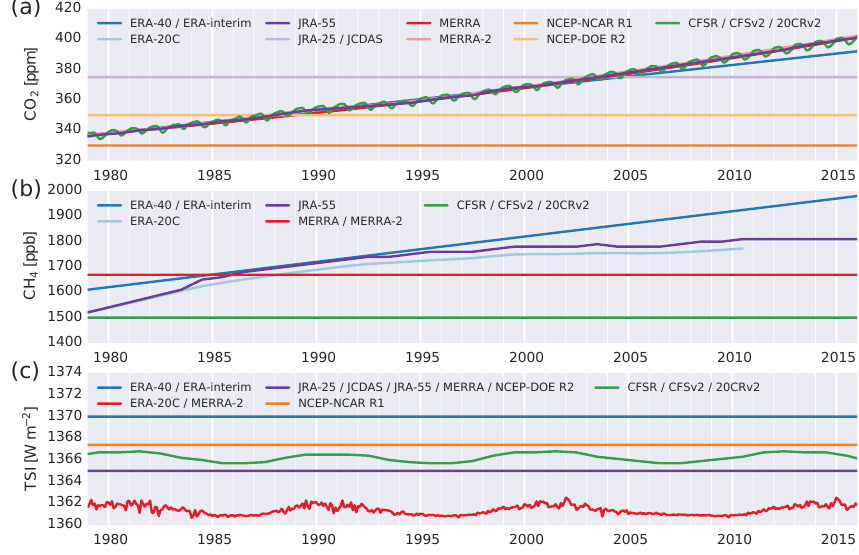
Figure 4. Time series of boundary conditions for (a) CO 2 , (b) CH 4 , and (c) TSI used by the reanalysis systems from 1979 through 2015. The CH 4 climatology used in MERRA and MERRA-2 varies in both latitude and height; here, a “tropospheric mean” value is calculated as a mass- and area-weighted integral between 1000 and 288hPa to facilitate comparison with the “well-mixed” values used by most other systems. ERA-20C also applies rescalings of annual mean values of both CO 2 and CH 4 that vary by latitude, height, and month; here, the base (global annual mean) values are shown. Time series of TSI neglect seasonal variations due to the ellipticity of the Earth’s orbit, as these variations are applied similarly (but not identically) across reanalysis systems. See text for further